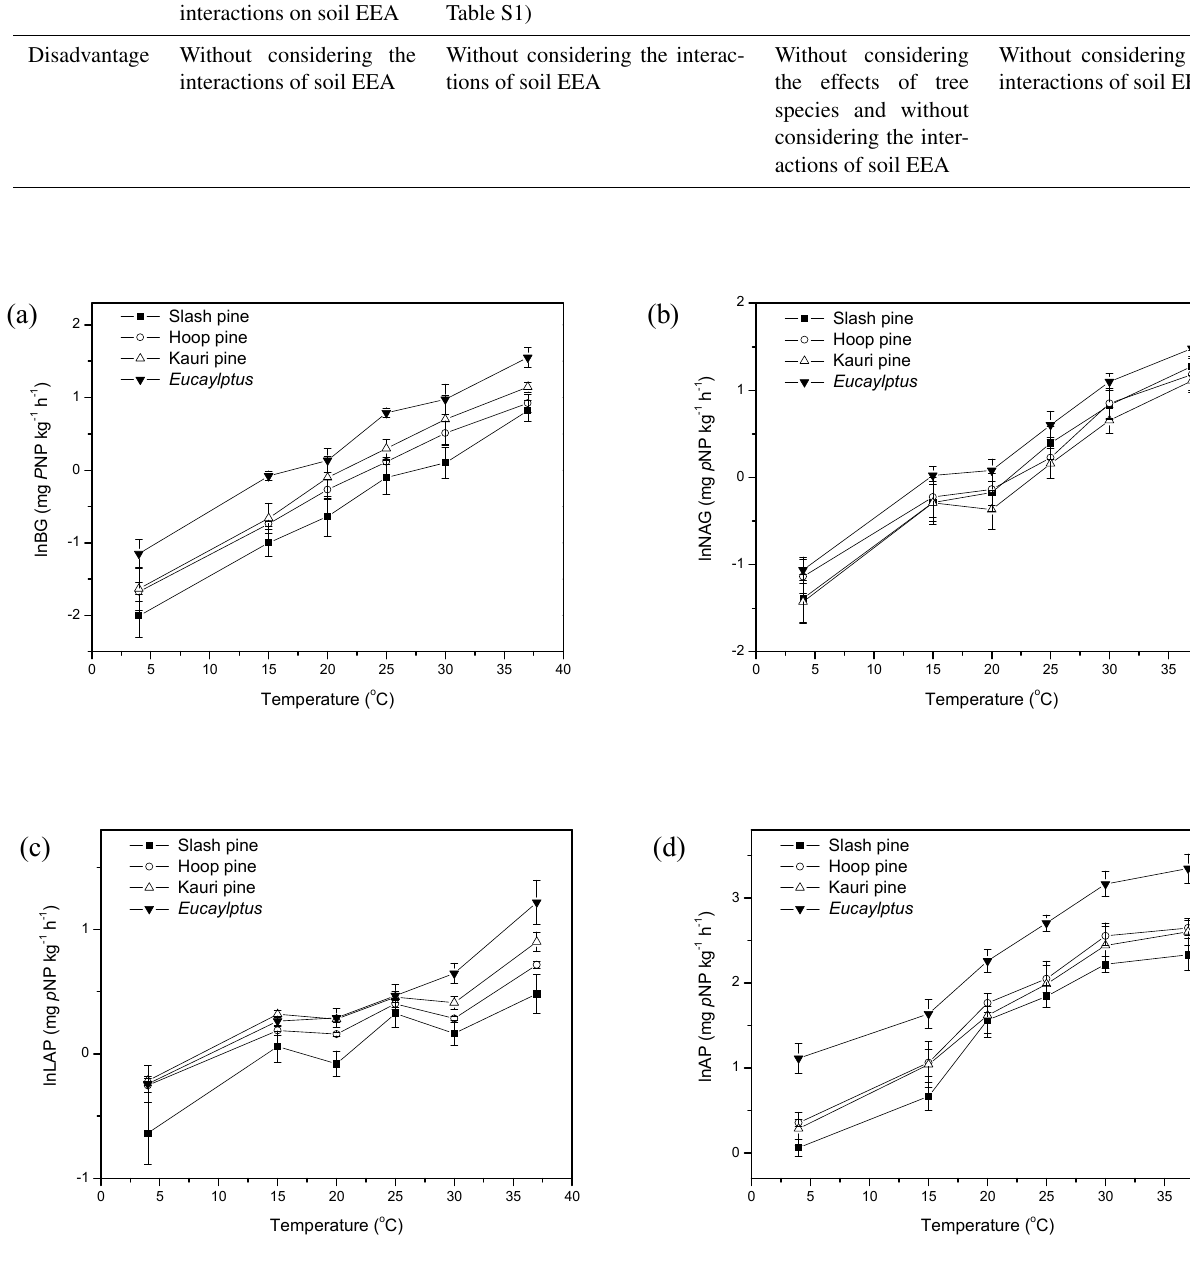
Figure 1. Extracellular enzyme activity in the soil along a gradient of temperatures under different tree species. (a) β -glucosidase (BG); (b) N -acetylglucosaminidase (NAG); (c) leucine aminopeptidase (LAP); (d) acid phosphatase (AP) and p NP, para